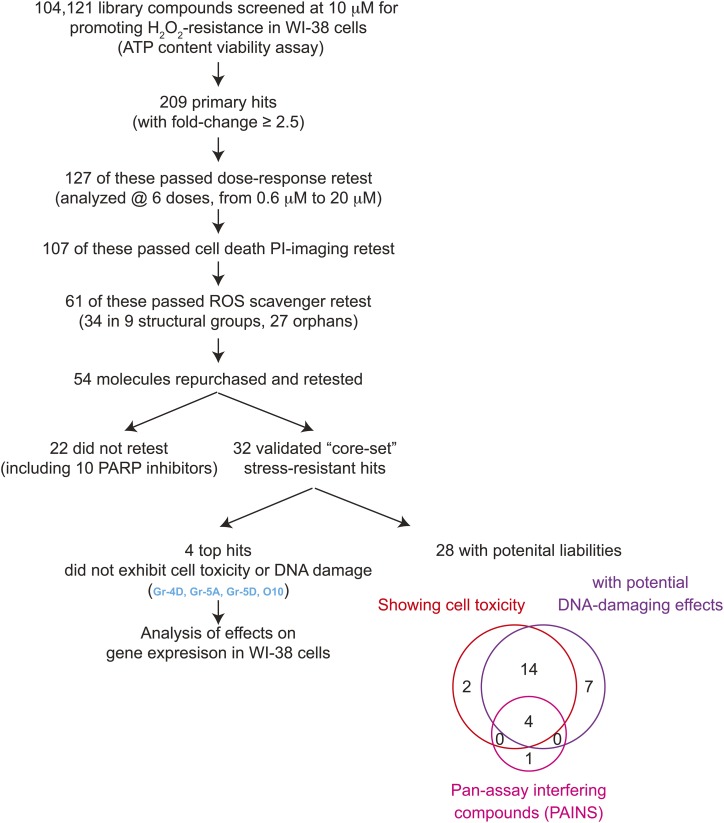
Summary of the small-molecule screen hits. A cell viability assay was performed for each of 104,121 compounds analyzed, by measuring ATP content, for WI-38 cells that were pre-incubated with 10 μM small molecules overnight and then treated with H2O2 for 3 hr. 209 primary hits were identified and subjected to a series of retests to eliminate false positives and ROS scavengers to yield the top 61 selected hits. Of these, a core set of 32 small molecules were validated and further analyzed in cells and in worms. Many molecules showed cell toxicity and potential DNA-damaging effects, and 4 top non-toxic molecules showing no liabilities were analyzed for their effects on gene expression in WI-38 cells.